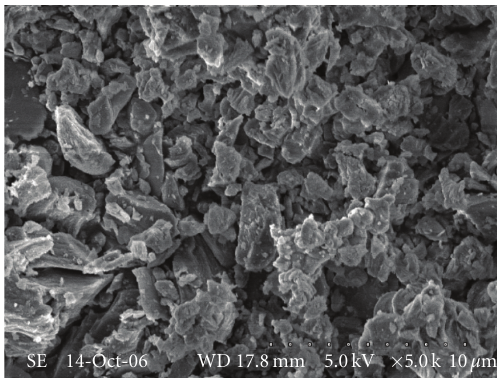
Figure 1: SEM picture of cFIR ceramic powder used in this study. based on past studies detailing related biomolecular factors and future